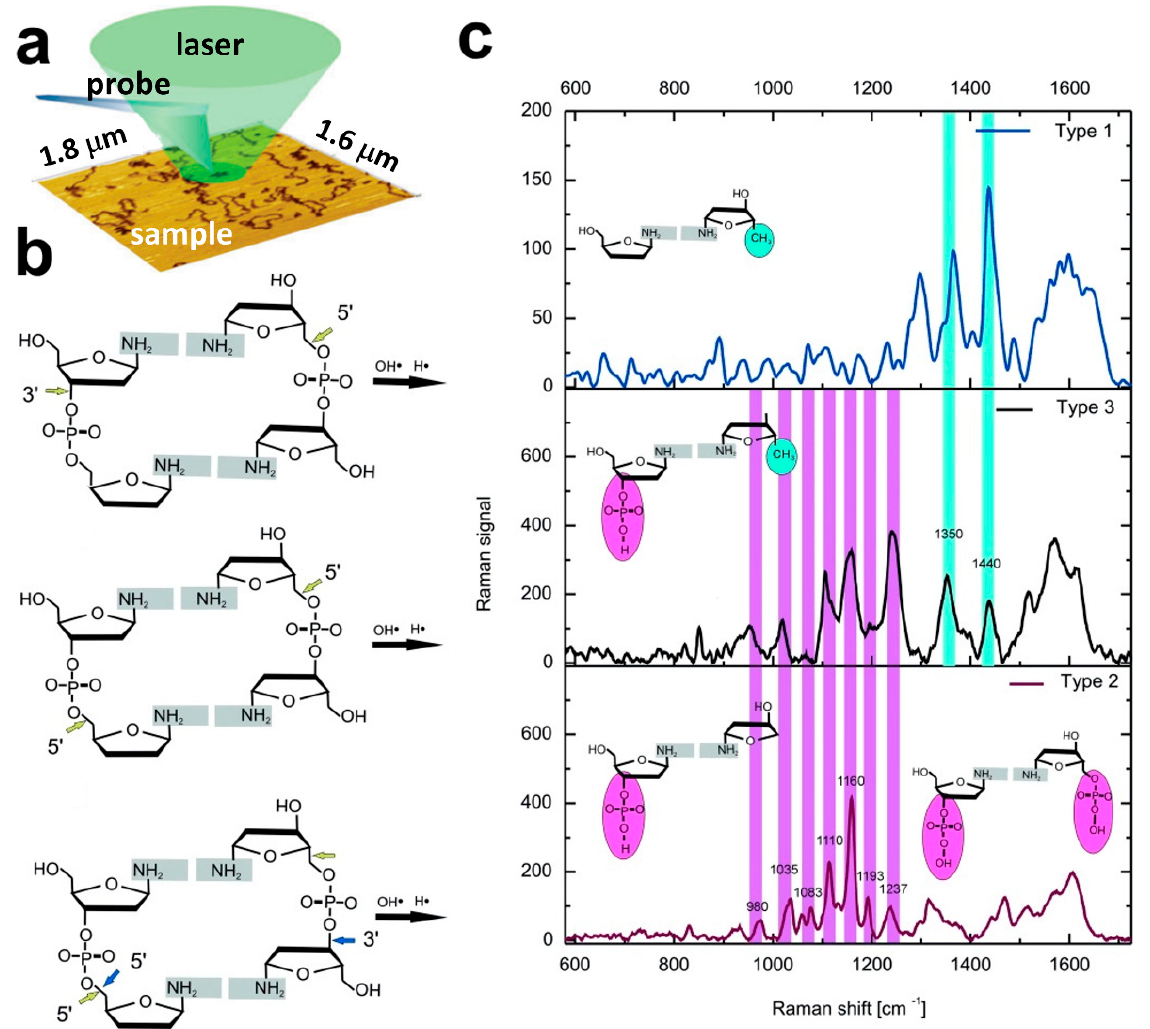
Figure 10. ( a ) A schematic representation of the TERS up-right setup suitable for DNA measurements. ( b ) Possible mechanisms of DNA double-strand breaks formation. ( c ) Spectra acquired from DNA lesions sites indicating DNA backbone rupture according to schemes presented in ( b ). Reproduced with permission from Lipiec, E.; Angew. Chem.—Int. Ed. , published by Wiley-VCH GmbH, Weinheim, 2014.